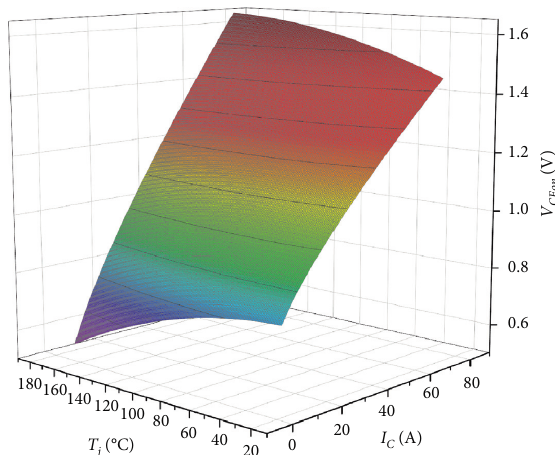
Figure 6: The three-dimensional space which is composed of junction temperature, collector current, and on-state